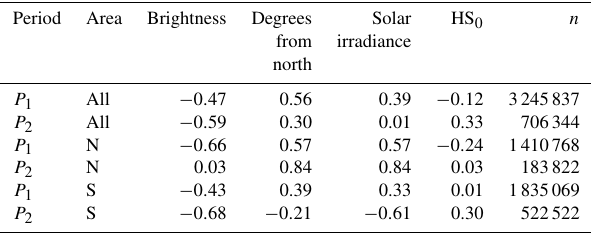
Table 1. Pearson correlations coefficient ( r ) between dHS and the explanatory variables. P 1 is from 19 May to 1 June and P 2 is from 1 to 24 June. n is number of